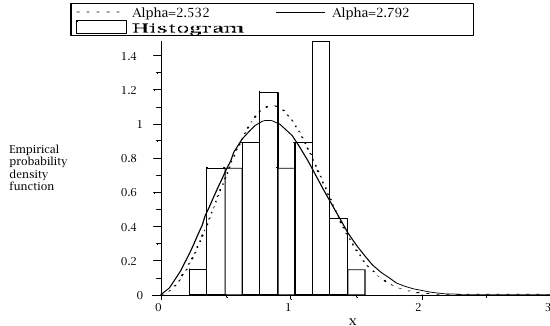
Figure 10 – Histogtram of simulated data for 3 (cid:68) (cid:32) , 1 (cid:69) (cid:32)